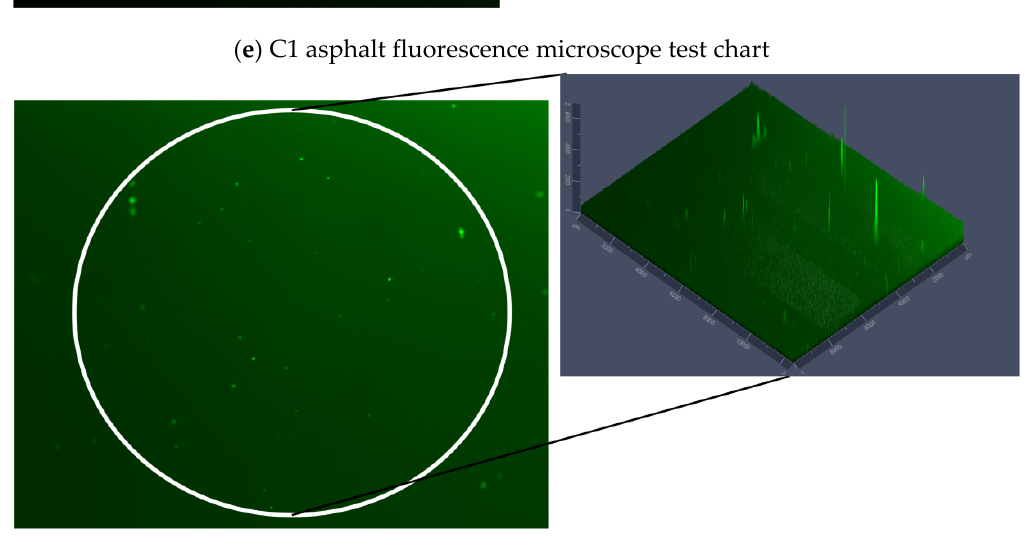
Figure 9. Fluorescence microscope observation plan and 2.5D view test chart for two asphalts with different aging levels. different aging